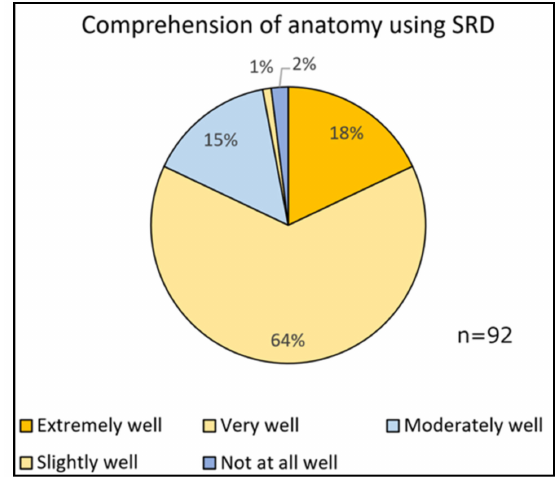
Figure 11. Comprehension of